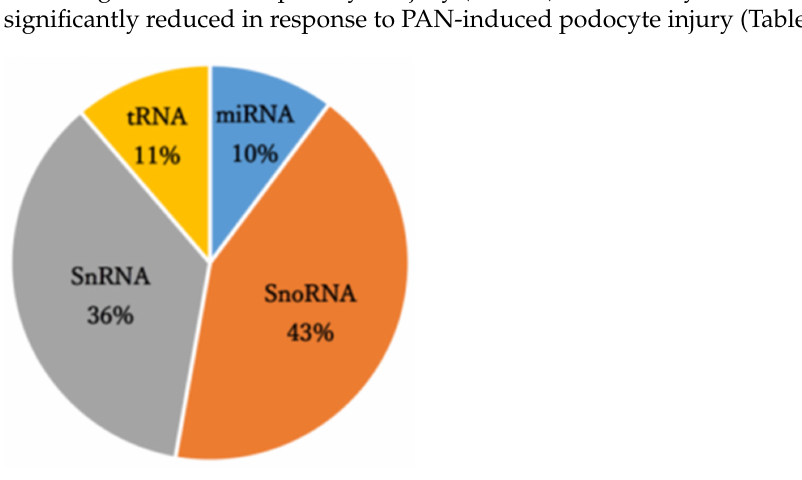
Figure 1. Small RNA class composition of the small RNA sequencing-derived reads. Table 1. miRNAs dysregulated in PAN-treated podocytes.